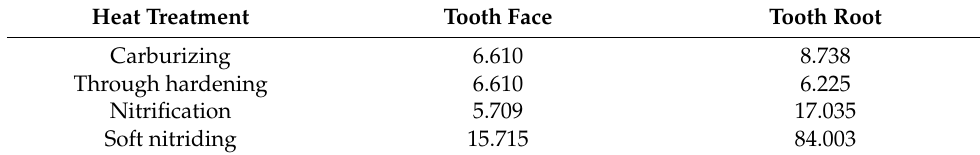
Table 5. Fatigue damage index for tooth face and root in ISO 6336 standard.